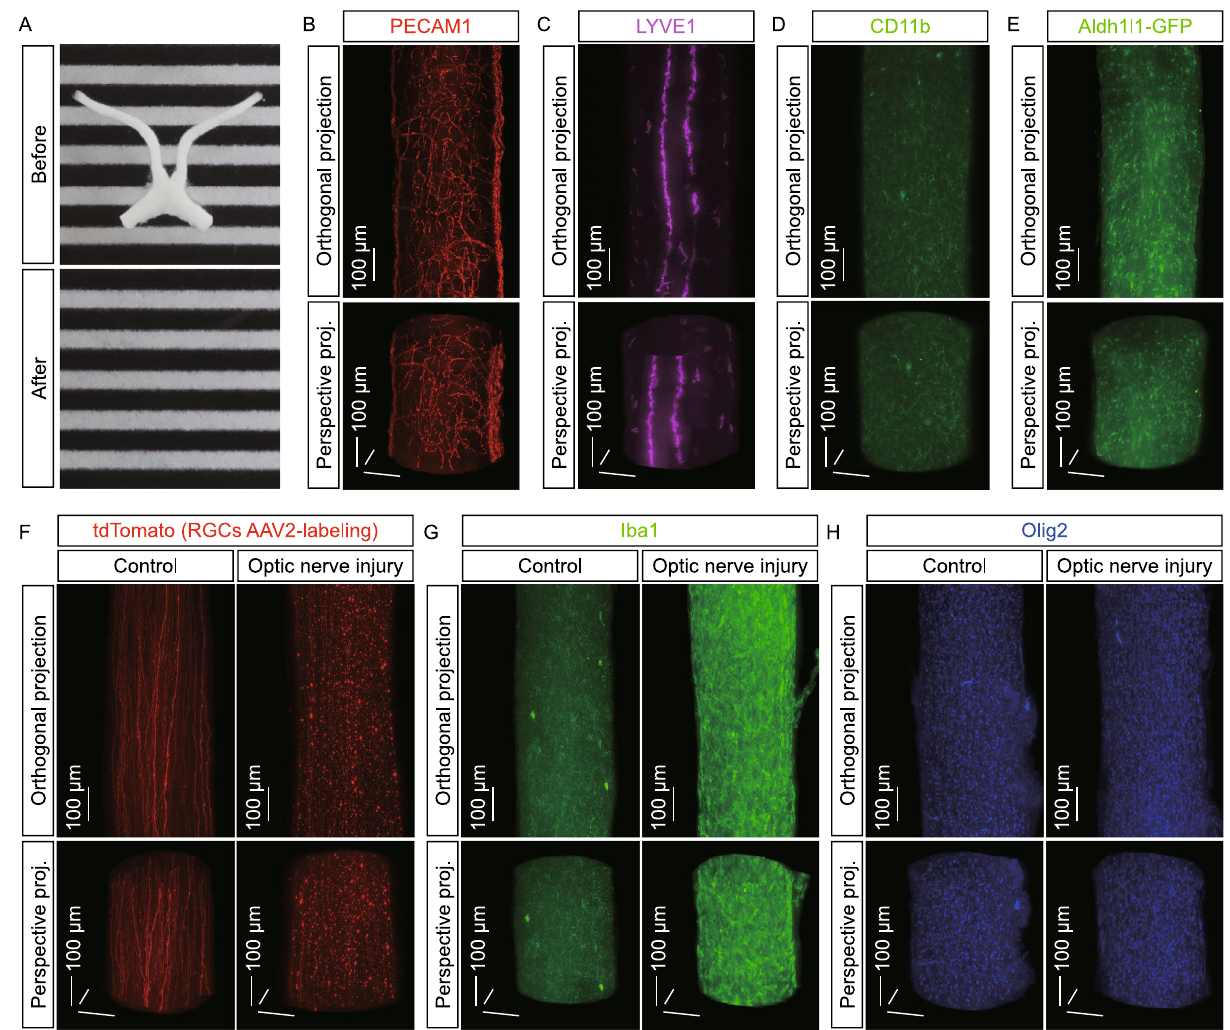
Figure 1. Three-dimensional fl uorescence imaging of microglial activation in response to neurodegeneration. (A – E) 3D fl uorescence imaging of the mouse optic nerves. (A) The optic nerves before (upper panel) and after (lower panel) the iDISCO procedure. (B – D) The optic nerves of wildtype mice were processed for the whole-tissue immunolabeling of PECAM1 (B), LYVE1 (C) or CD11b (D) and imaged on the lightsheet microscope. (E) The optic nerves of Aldh1l1-GFP transgenic mice were processed for the whole-tissue immunolabeling of GFP and imaged on the lightsheet microscope. Representative orthogonal (upper panels) or perspective (lower panels) 3D-projection images of the optic nerves are shown. (F) 3D fl uorescence imaging of the traumatic injury- induced neurodegeneration. The wildtype mice were intravitreally injected with the tdTomato-expressing AAV2 and then subjected to optic nerve injury. The control (i.e., uninjured) and injured nerves were processed for the whole-tissue immunolabeling of tdTomato and imaged on the lightsheet microscope. Representative orthogonal (upper panels) or perspective (lower panels) 3D-projection images of the optic nerves are shown. (G and H) 3D fl uorescence imaging of the glial responses to neurodegeneration. The wildtype mice were subjected to optic nerve injury. The control and injured nerves were processed for the whole-tissue immunolabeling of Iba1 (G) or Olig2 (H) and imaged on the lightsheet microscope. Representative orthogonal (upper panels) or perspective (lower panels) 3D-projection images of the optic nerves are